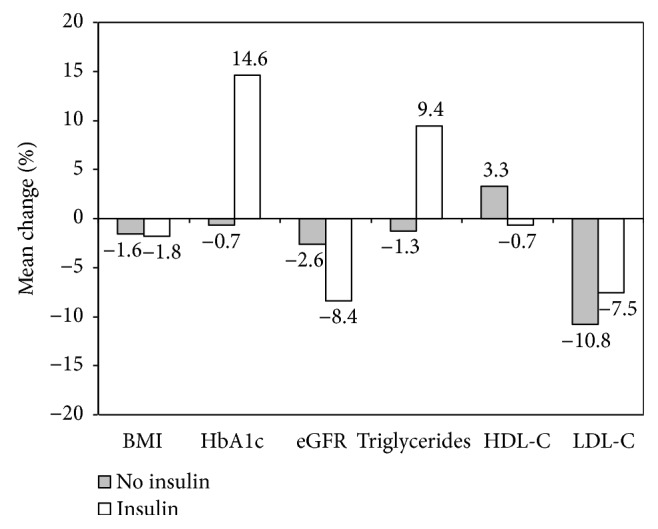
Change (%) from baseline by insulin treatment of main significant parameters identified by multivariate analysis. All differences were statistically significant (p < 0.001). Patients with less than one-year follow-up duration were excluded. Numbers of paired observations at baseline and final visits were: BMI 193238, HbA1c 227368, eGFR 183858, Triglycerides 171670, HDL-C 164966, LDL-C 160112, respectively.